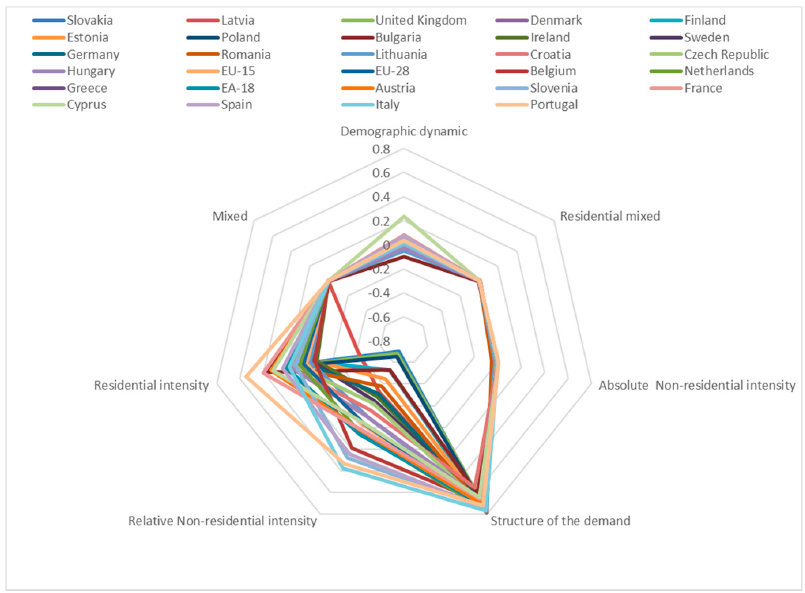
Figure 5. Average decomposition of Elasticity Demand to GDP. Source: Own calculations with Eurostat data.